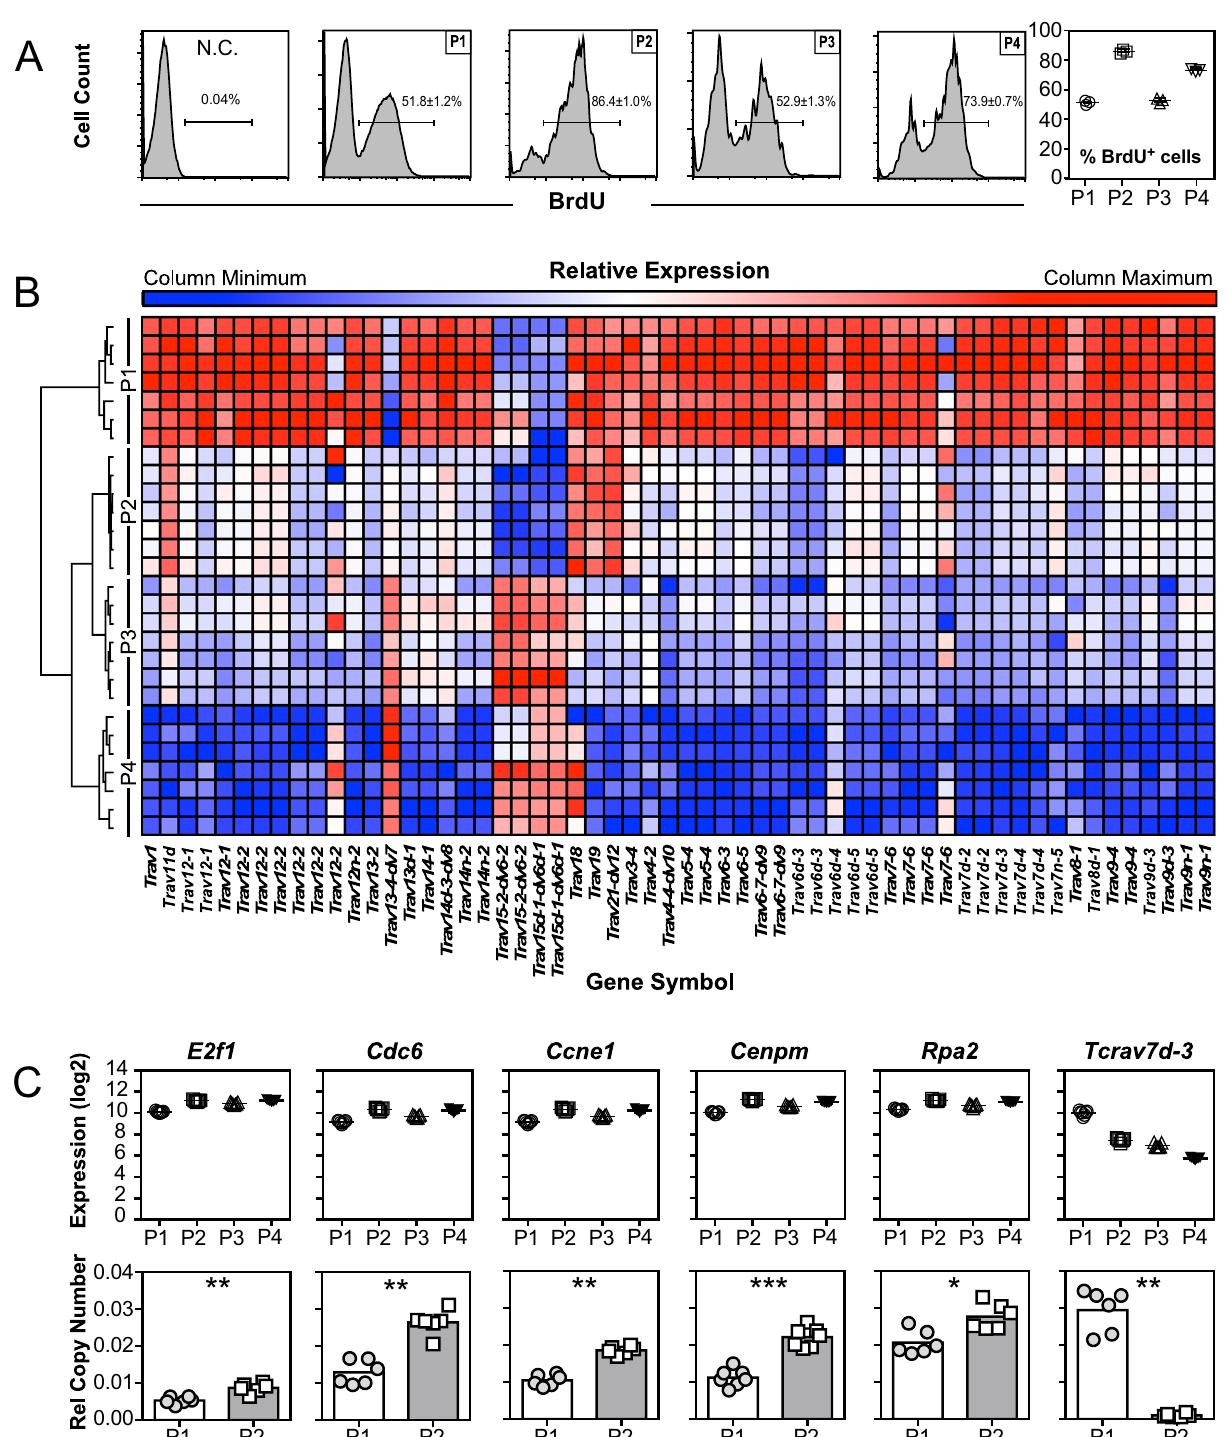
Figure 5. Generation of undirected, weighted transcriptional regulatory network from thymic NKT cell subsets. ( A ) Representative histograms and dot plot displaying proportion of BrdU positive cells among DP T (P1), DP NKT (P2), CD4 NKT (P3) and DN NKT (P4) cells compared to a non-injected control (NC). ( B ) Heat map of endogenous TCR alpha chain loci expression determined by microarray of the four different cell types across the three transitions as visualised in Cytoscape 3.8.0 (https:// github. com/ cytos cape/). ( C ) Expression profiles of genes associated with the cell cycle and cell division. Gene expression as determined by microarray (top row; n = 7/grp) and confirmed by qPCR on an independent cohort (bottom row; n =